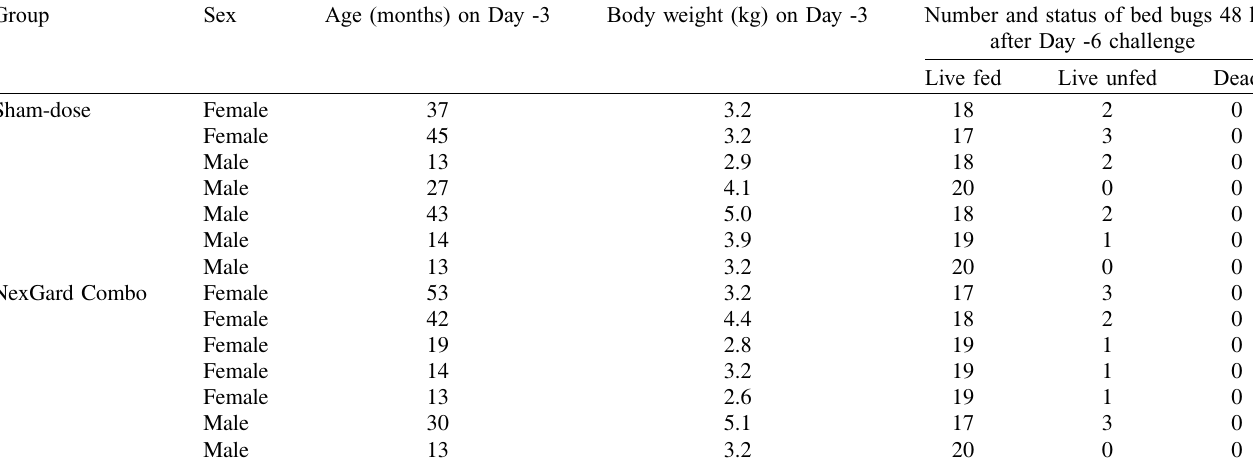
Table 1. Animal, and randomization details.